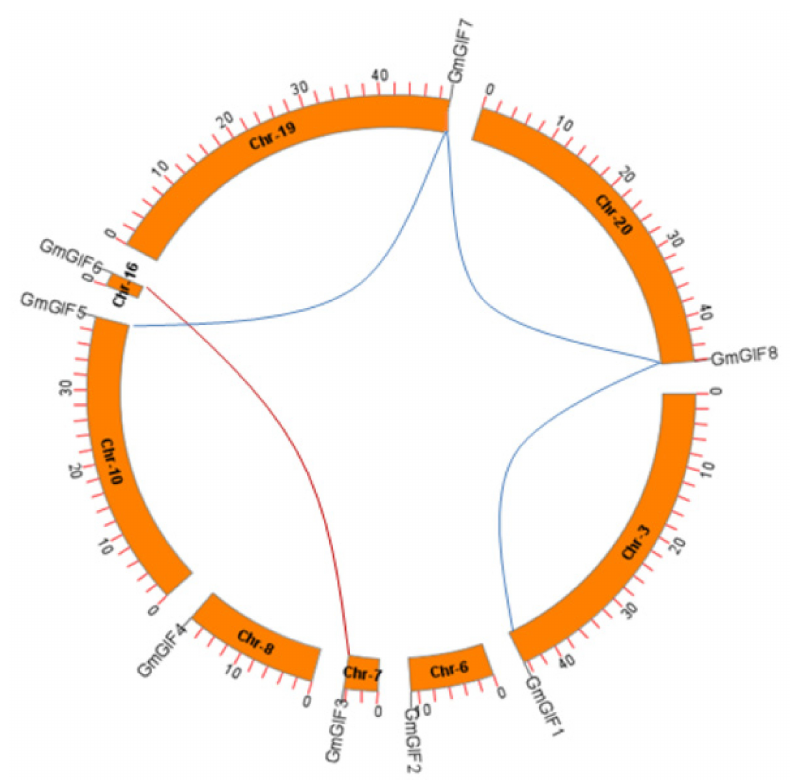
Figure 3. Distribution of GmGIF genes on eight chromosomes of soybean. The GmGIF genes are distributed throughout the chromosomes’ conserved collinear blocks. The number of chromosomes (Chr3, Chr6-Chr8, Chr10, Chr16, Chr19, and Chr20) is labeled in the center of each chromosome. The gene name and physical location (Mb) are shown on the upper positions of different chromo- somes. The duplicated genes’ positions are connected to the same color lines as the correspond- ing